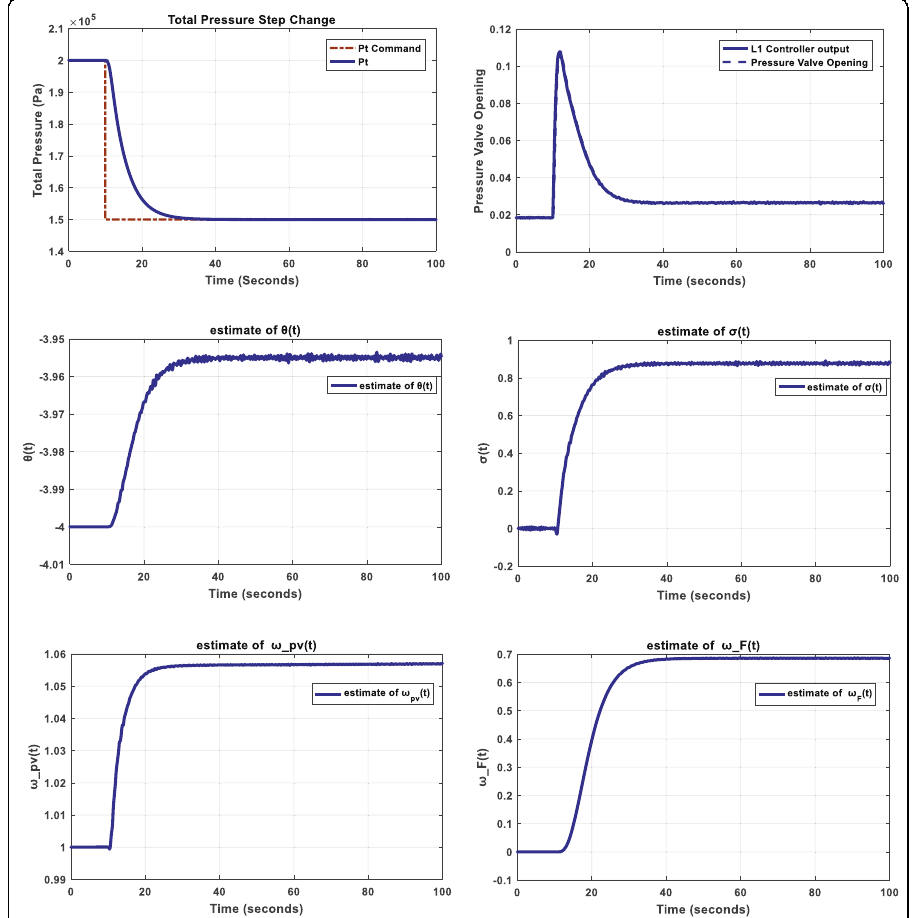
Fig. 4 Stagnation pressure control from 200 kPa to 150